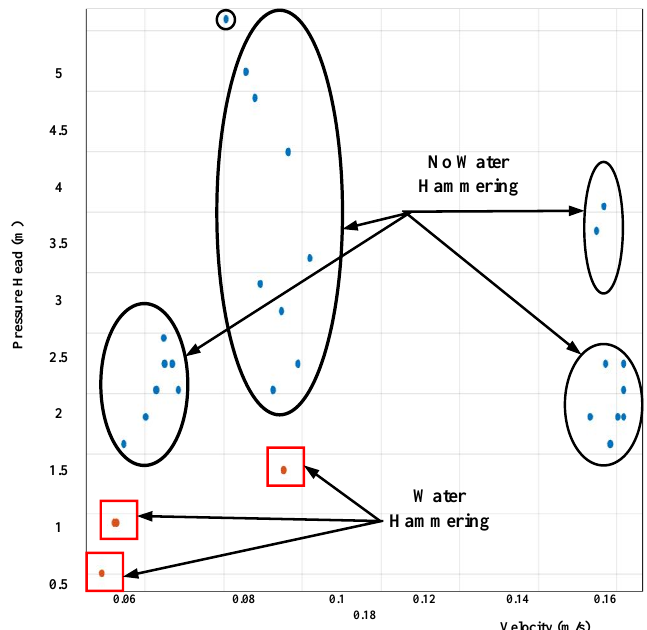
Figure 9. Regression analysis for fault detection .